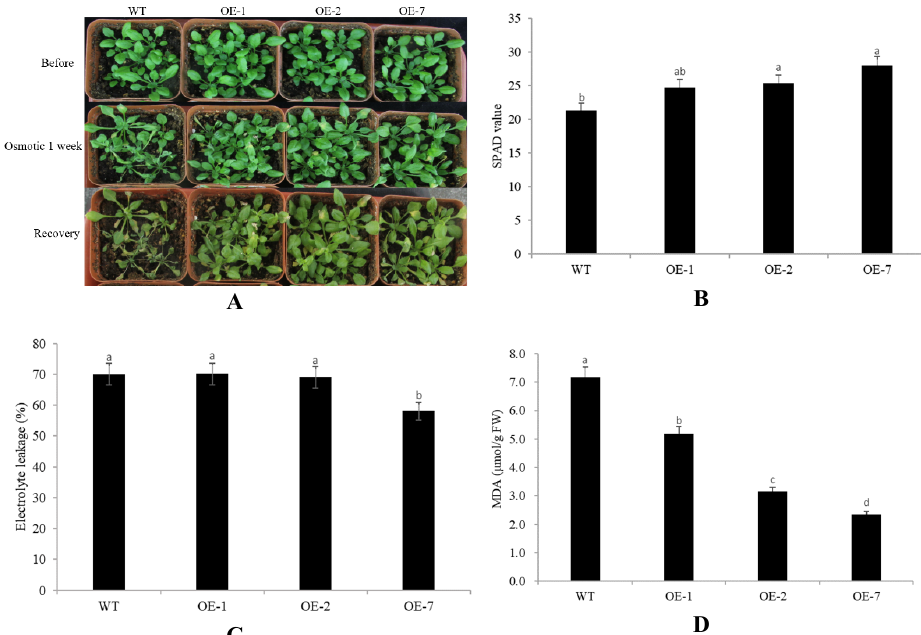
Figure 6. Ectopic expression of CpNAC68 confers improved tolerance to osmotic stress in transgenic Arabidopsis. ( A ) Performance of OE lines and WT plants after osmotic stress for 1 week, followed by recovery at normal conditions for 3 days. Images were taken at the indicated time points. ( B ) SPAD values of OE lines and WT plants under osmotic treatment. ( C ) Electrolyte leakage of OE lines and WT plants under osmotic treatment. ( D ) MDA content of OE lines and WT plants under osmotic treatment. Data represent the averages of three independent repeated trials. Values represent the mean ± SE. Bars correspond to the standard error. The significance test was performed by Duncan’s multiple range test, which is indicated by different letters.